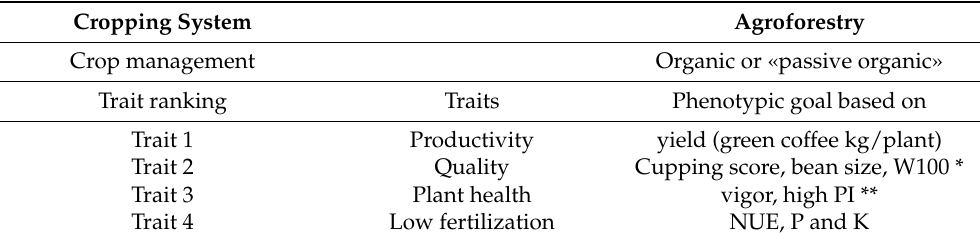
Table 1. Objectives in passive organic agroforestry cropping systems with a list of principal traits that are to be part of the coffee ideotype breeding initiative with a phenotypic goal for each of them. (* 100 grain-weight, ** Performance